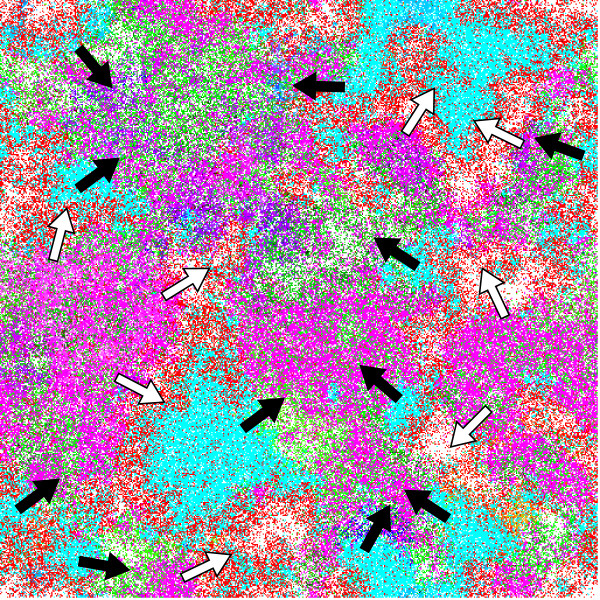
A snapshot of a simulation. μ = 0.004. The snapshot depicts mutually invading wave patterns. Molecules are colored in the same way as in Fig. 2. In this color scheme, the wave fronts composed of the C-catalyst appears cyan; the wave backs composed of the G-parasite appear red; the wave fronts composed of the A-catalyst appear magenta; the wave backs composed of the U-parasite appear green. Empty space is white. The arrows represent the direction of the propagation of wave fronts. The black arrows are for the C-catalyst fronts, whereas the white arrows are for the A-catalyst fronts. A movie of this simulation is available as Additional file 1.